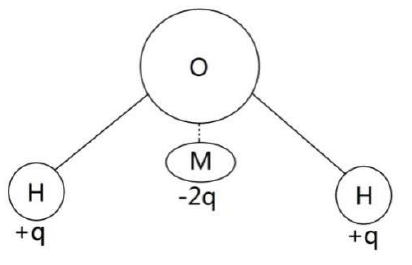
Figure 1 : Molecular geometry of TIP4P model for